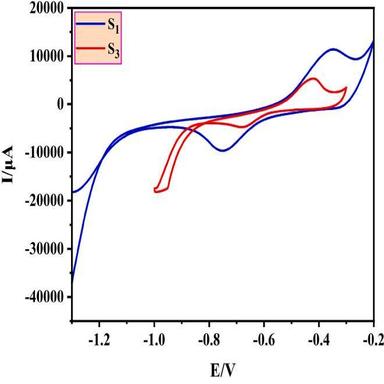
Comparative cyclic voltammograms of S1 and S3 nanostructures.